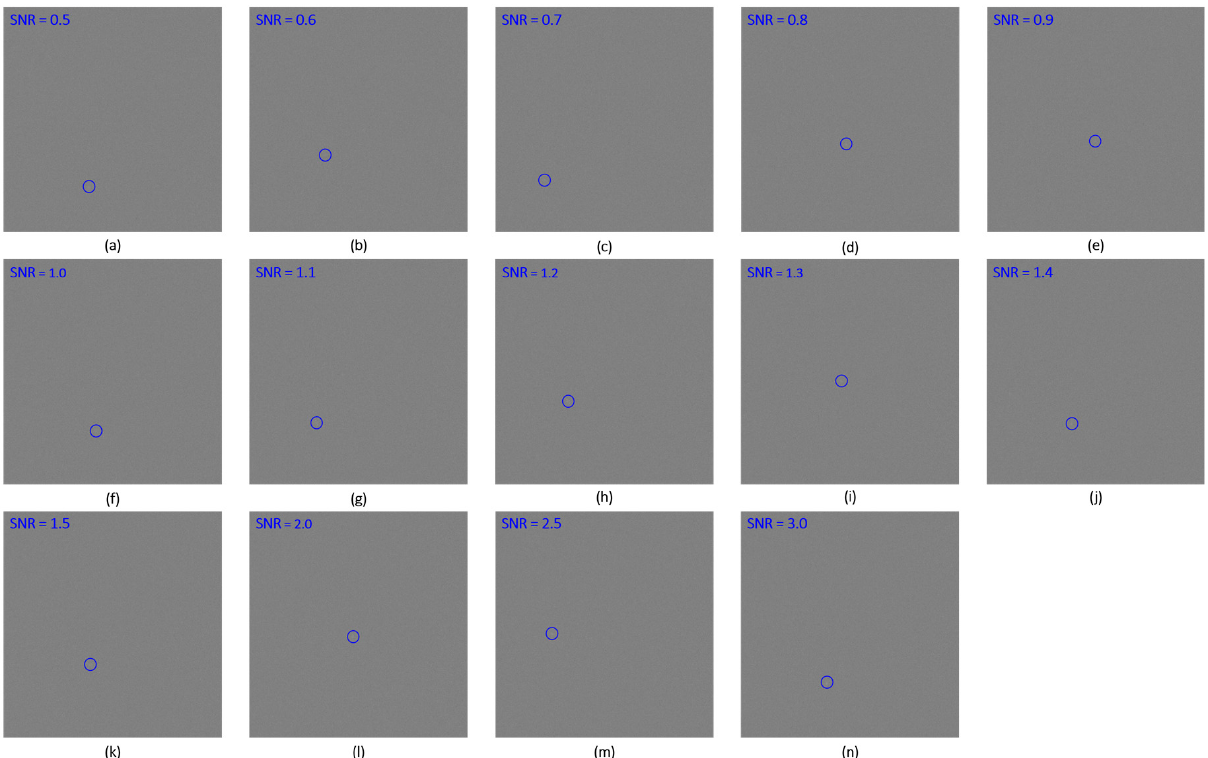
Figure 11. Schematic diagram of 14 sets of simulation data: ( a – n ) are the original images with different SNRs, the blue circle represents the target location.